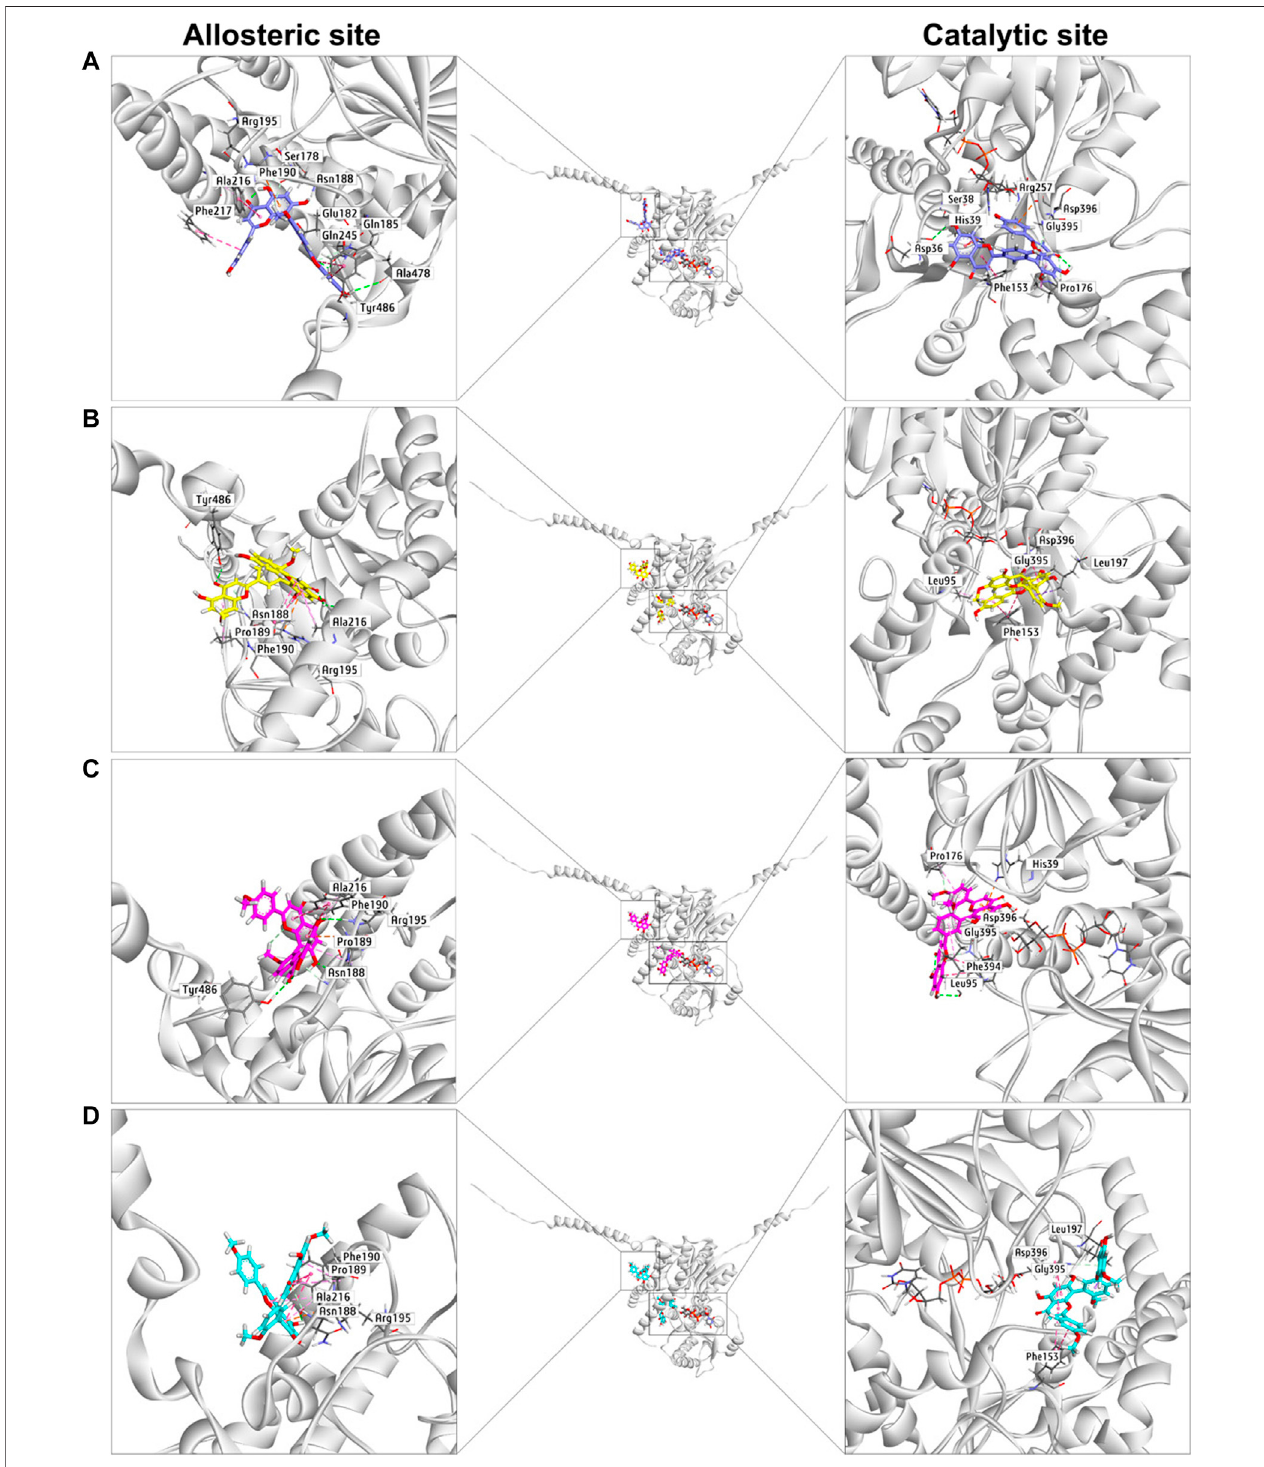
FIGURE 6 | The docking simulations of four bi fl avones (A) , bilobetin in purple, (B) , ginkgetin in yellow, (C) , isoginkgetin in magenta, (D) , sciadopitysin in cyan) in hUGT1A1 complexed with the sugar donor UDPGA (black).